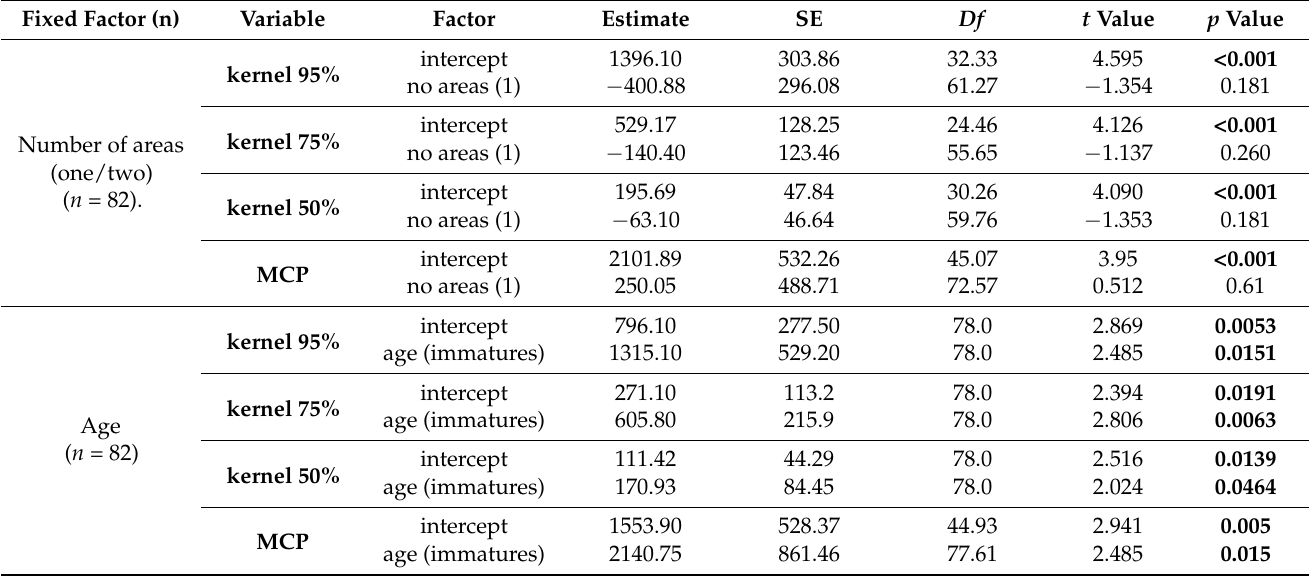
Table 3. Results of the linear mixed models (LMMs) of home range areas (km 2 ). We used wintering area as the sample unit, so two areas during the same wintering season were considered as separated areas. Number of wintering areas; age; and sex were considered fixed factors. Wintering event and individual identity were considered random effects. Estimate, standard error (SE), degrees of freedom (Df), t value and p value are shown for each LMM. MCP—minimum convex polygon. α = 0.05. Bold indicates p Value < α